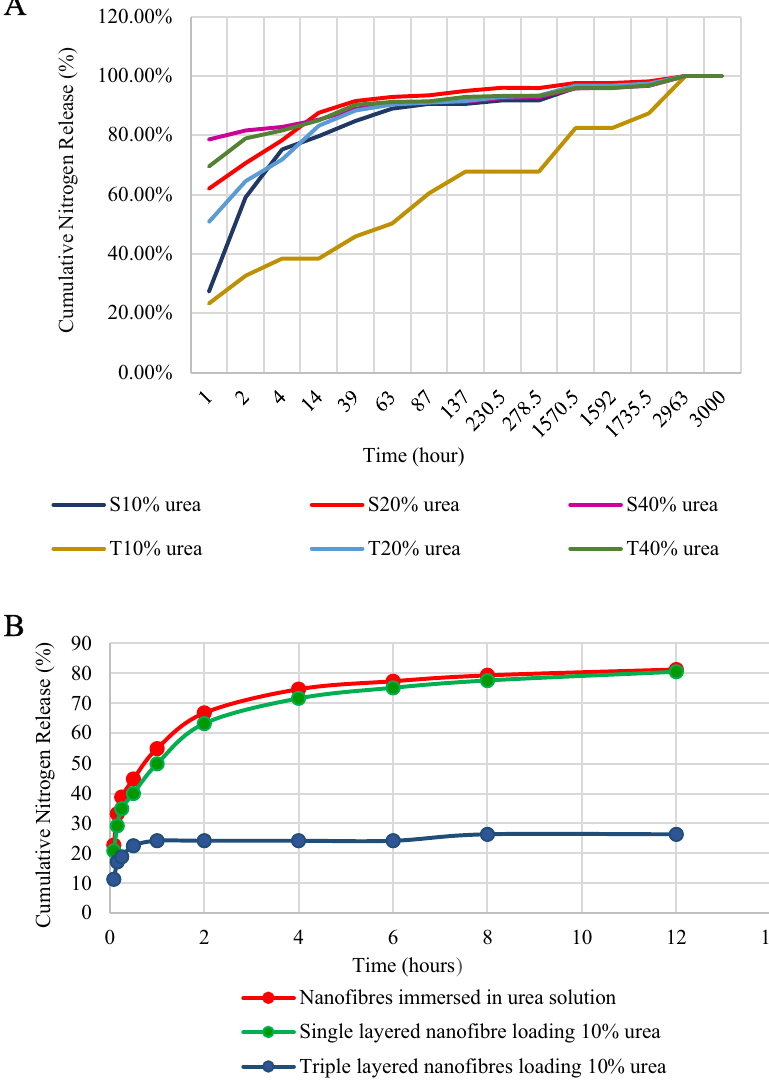
Figure 3. ( A ) Cumulative nitrogen release from single- and triple-layer nanofibre structures from first hour until 3000 hours, and ( B ) Cumulative nitrogen release from immersed nanofibres in urea solution and single-, triple-layer nanofibrous structure containing 10% urea from first hour until 12 hours. S single-layered PLLA nanofibre mat, T triple-layered PHB/PLLA/PHB nanofibrous structure.